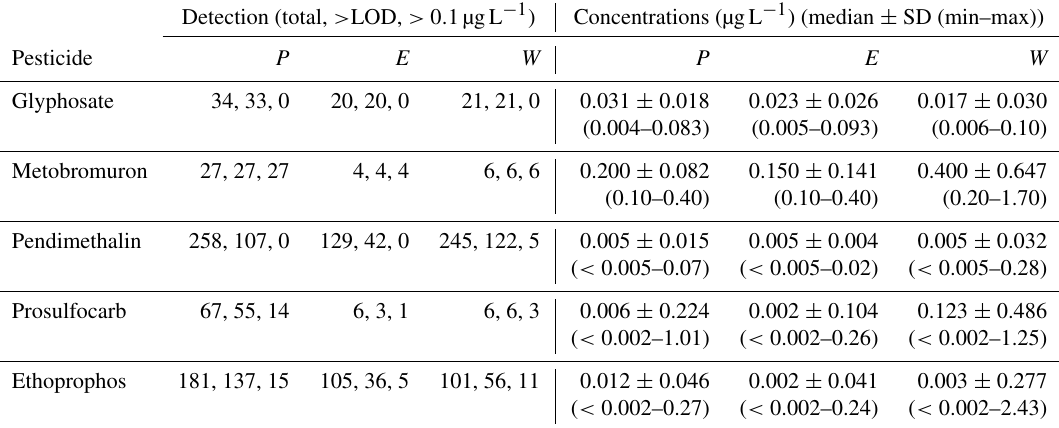
Table 1. Summary of the pesticide monitoring data by location (P: Pump; E: East stream; W: West stream) in the Val de la Mare (VDLM) catchment from 2016 to 2019. Detection data are summarised as the total number of samples, the number of samples above the limit of detection (LOD), and the number of samples above the drinking water standard of 0.1µgL − 1 . The concentration data are summarised as the median ± standard deviation (SD), and the range (minimum to maximum) of the observed concentrations is given in parentheses. Detection (total, > LOD, > 0 . 1µgL − 1